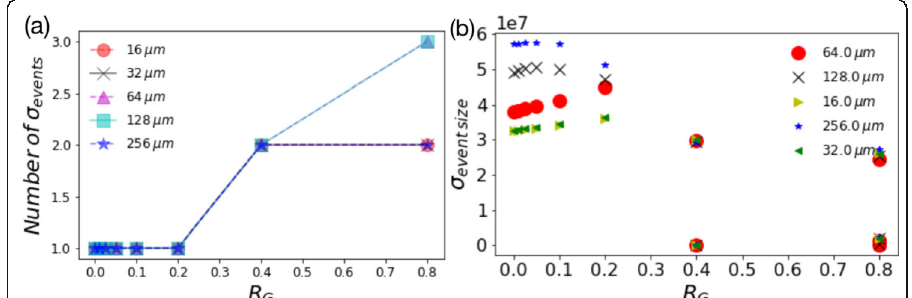
Fig. 10 Significant Stress Events for Brittle and Quasi-brittle Fracture: The number and size of the stress events were measured as a function of RG where ( a ) is a series of histogram curves for various W and ( b ) is a plot of the event size for various W. The figure legends signify the notch width W that varies from 16 to 256 μ m